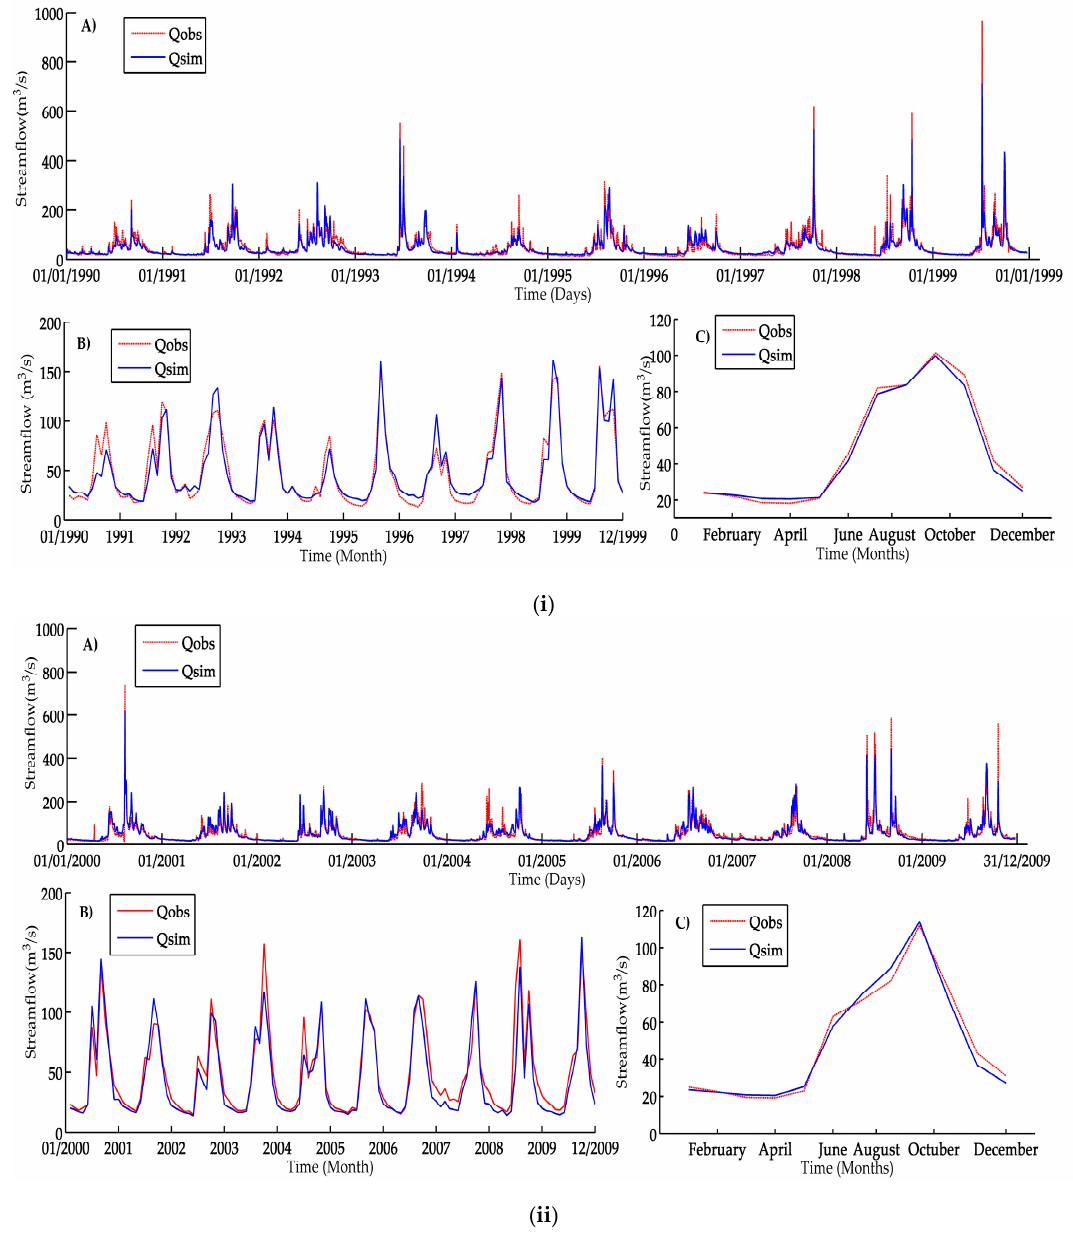
Figure 3. ( i ) calibration and ( ii ) validation. ( A ) daily hydrograph; ( B ) monthly hydrograph and ( C ) hydrograph monthly average. Qsim refers to simulated streamflows, while Qobs refers to observations.